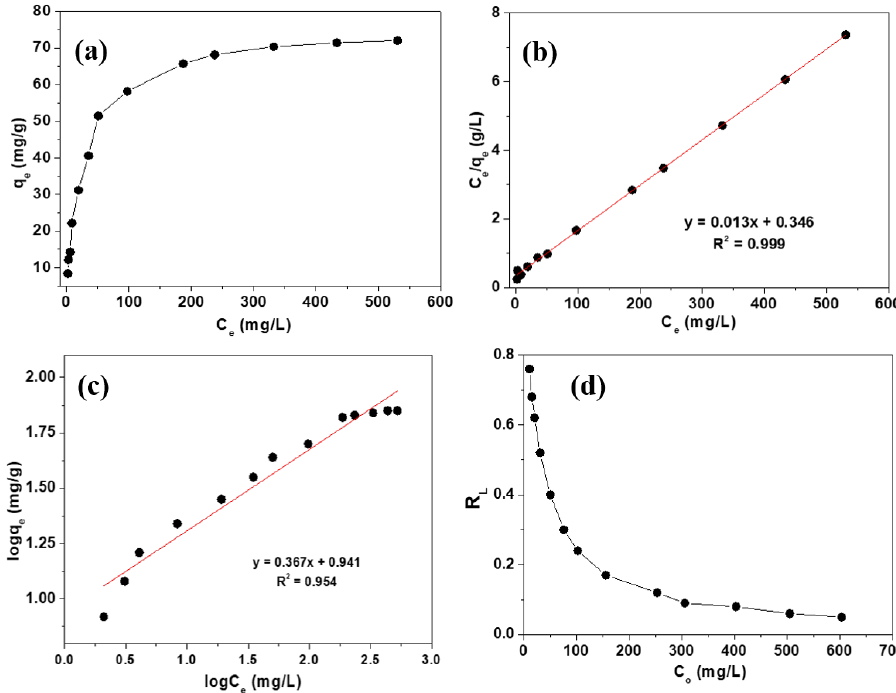
Figure 3. ( a ) Adsorption isotherm of As(III) using PP@TiO 2 from water; ( b ) modeling of experimental data using Langmuir isotherm; ( c ) modeling of experimental data using Freundlich isotherm; ( d ) variation of R L with initial As(III) concentration. (Conditions: V/m = 1000 mL/g, concentration of As(III) = 10–600 mg/L, pH = 7, T = 25 °C, contact time = 24 h).